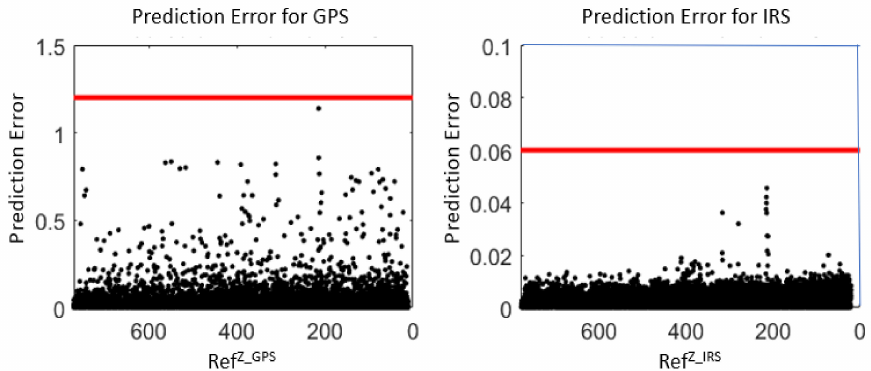
Figure 18. Envelopes for GPS and IRS using real